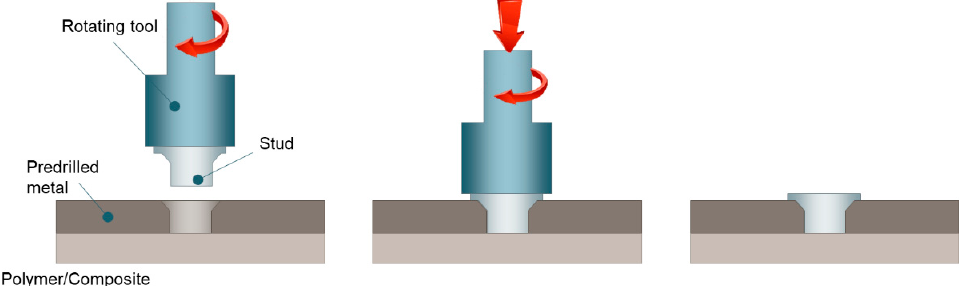
Figure 12. Schematic of the friction-based filling stacking process.